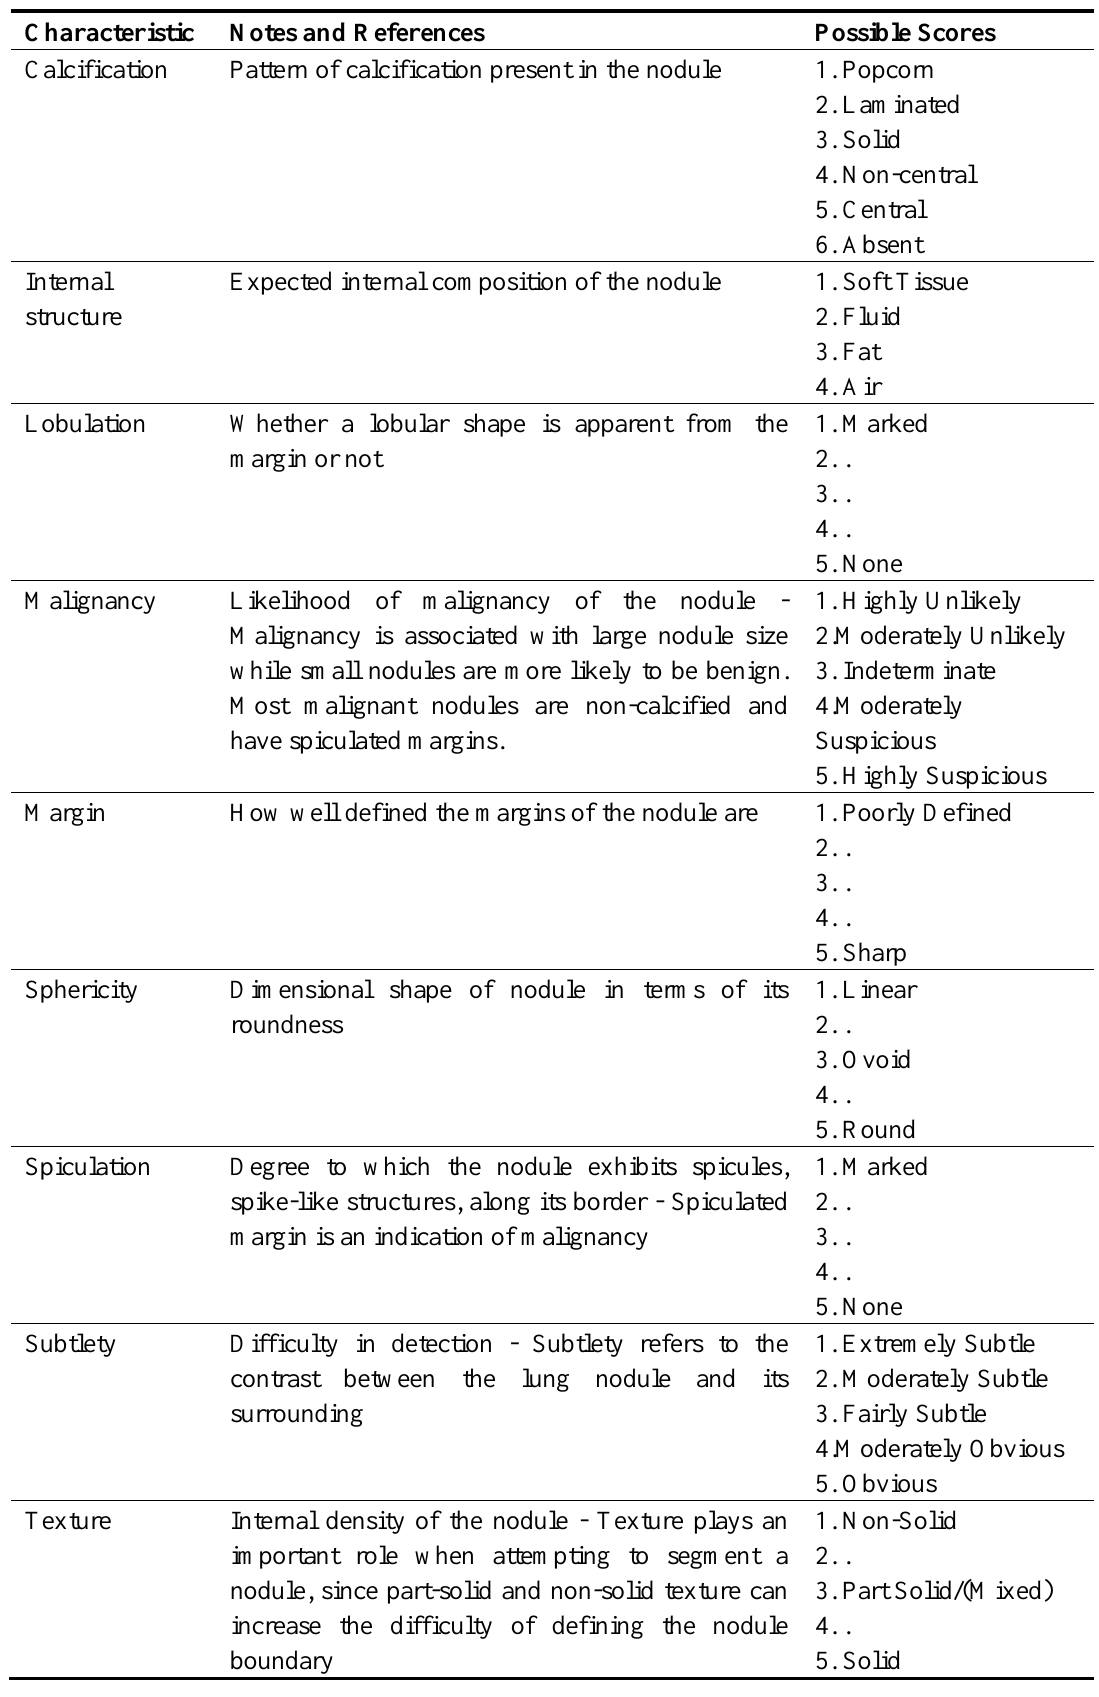
Table 2. LIDC nodule characteristics with corresponding rating